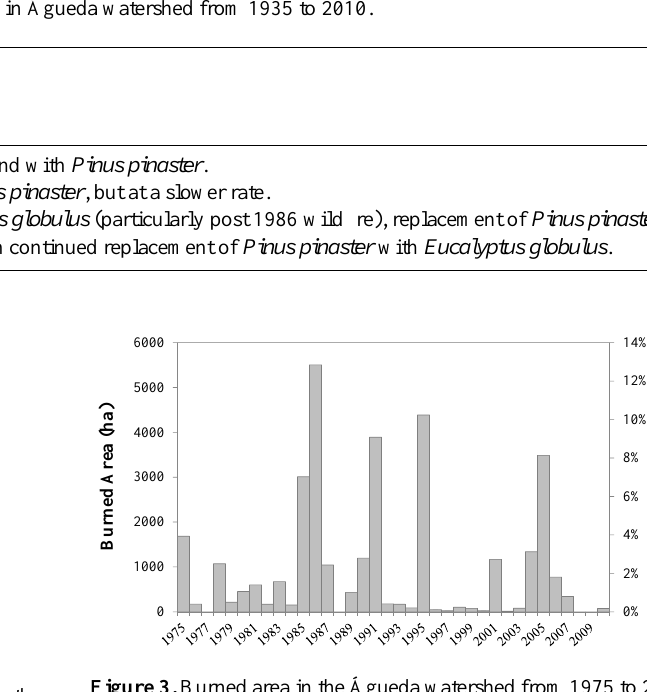
Figure 2. Average monthly precipitation and temperature in the Águeda watershed from 1971 to 2000.